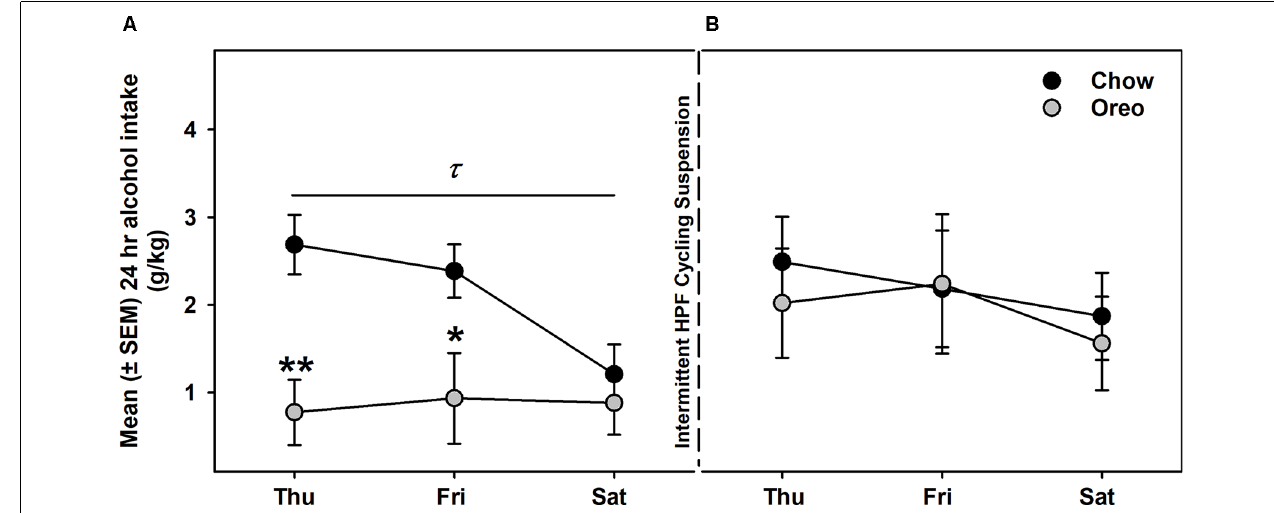
FIGURE 6 | Alcohol intake following suspension of patterned HPF cycling. Data compares the mean ( ± SEM) alcohol intake (g/kg) between (A) the 5th week of regular alcohol testing and (B) after a week of patterned HPF cycling suspension. While the Oreo group had a significantly reduced alcohol consumption as compared to chow in the 5th week, they returned to the chow controls drinking level when the patterned HPF cycling was suspended. τ p < 0.05 main effect of diet. * p < 0.05, ** p < 0.01 compared to chow controls.